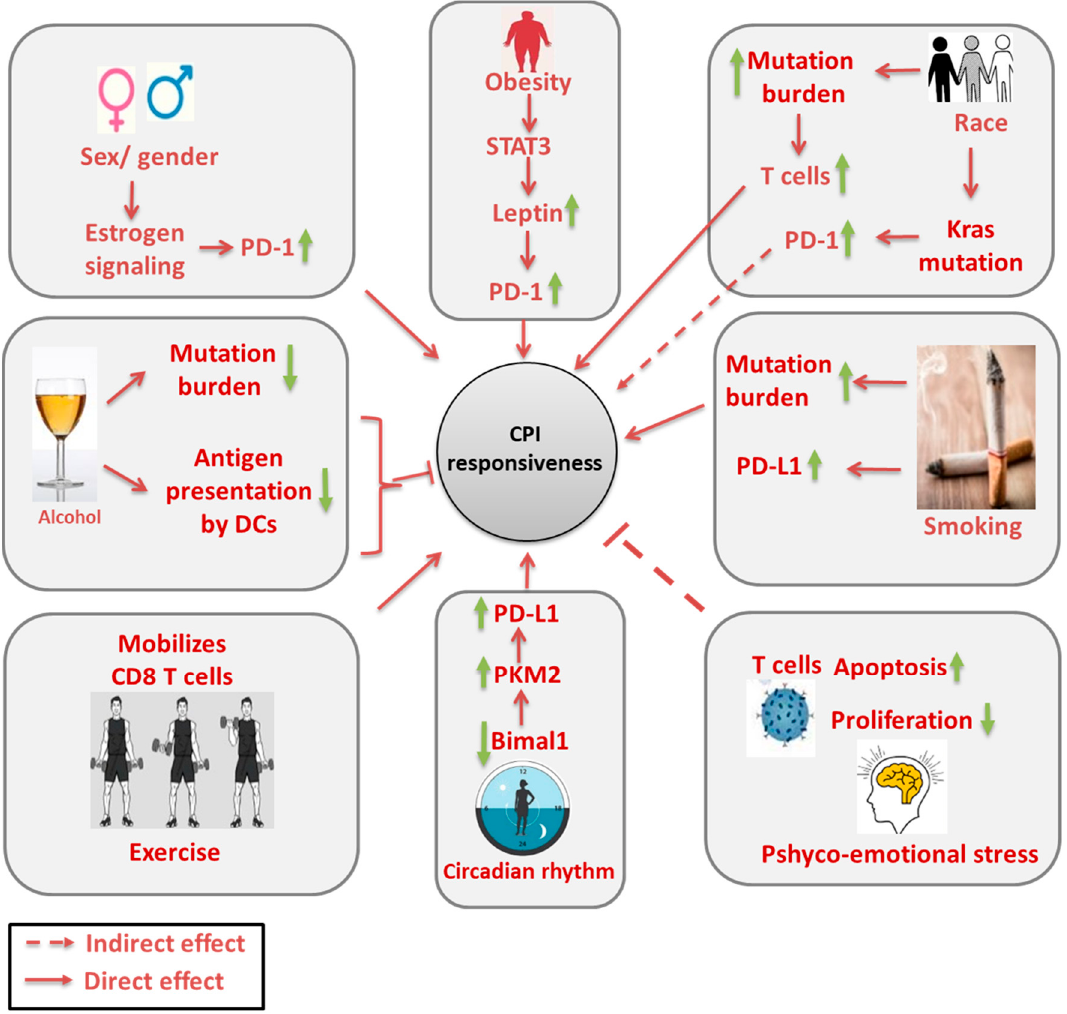
Figure 1. Various lifestyle and metabolic factors affect CPI effectiveness.